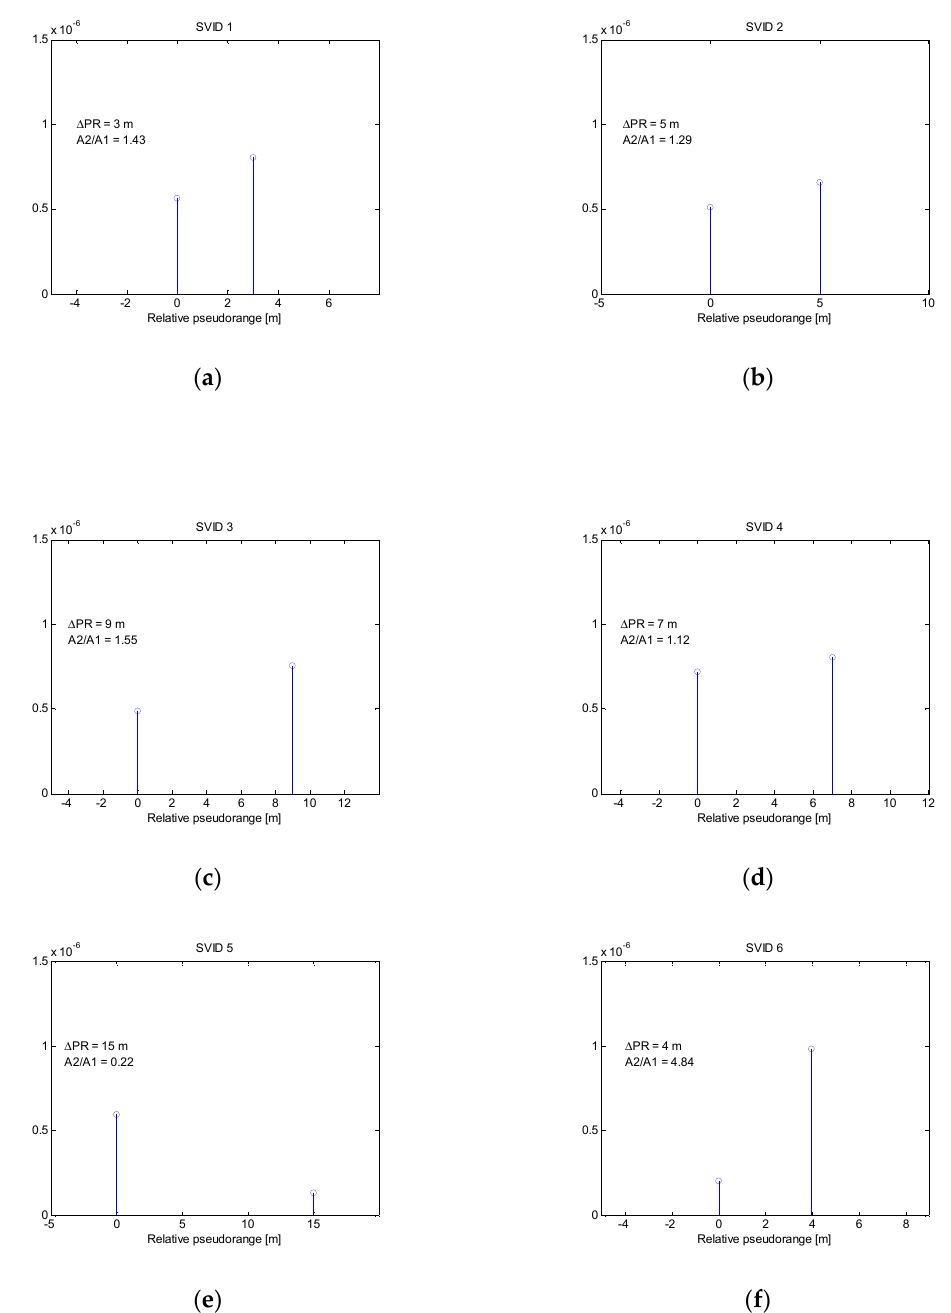
Figure 9. Multipath bins estimated in spoofing scenario 2 for signals related to SVIDs 1-6 ( a - f ).